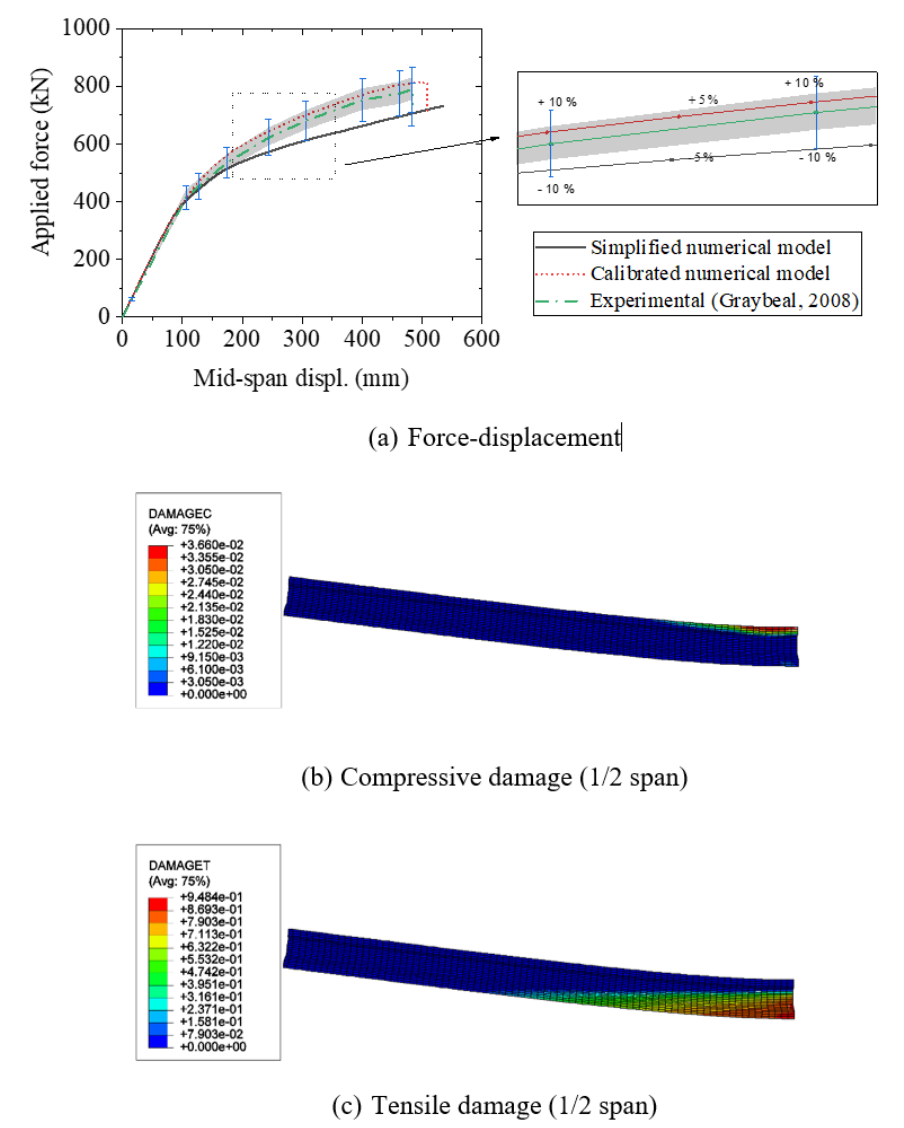
Figure 7 – Damage behavior of AASHTO PCI